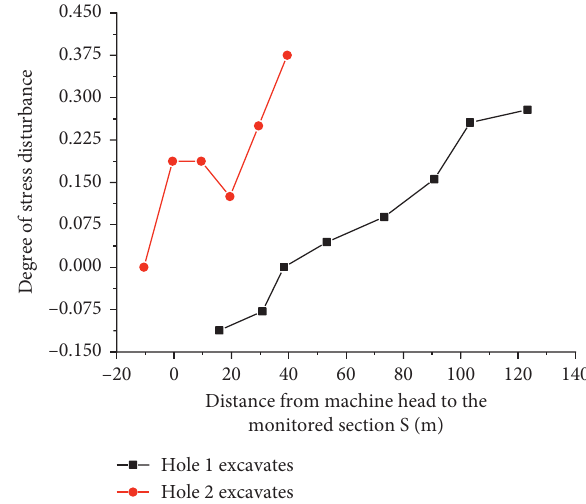
Figure 18: Analysis chart of double-hole overlap disturbance